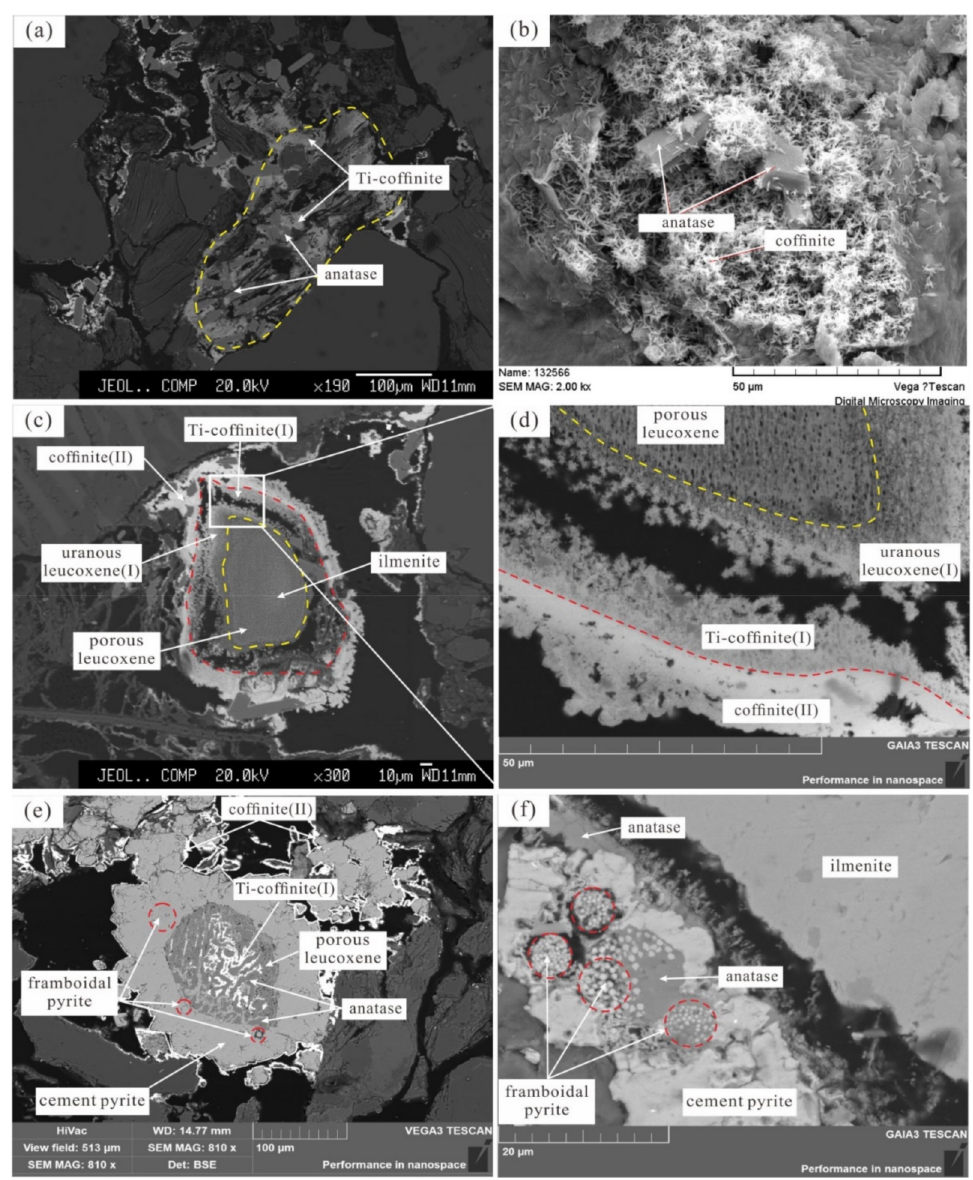
Figure 3. Alteration characteristics of altered ilmenite and its relationship with U minerals in sandstone-hosted U deposits in the Nalinggou U deposit in the northern Ordos Basin. ( a ) Completely altered ilmenite replaced by anatases and Ti-coffinite (BSE). ( b ) Coffinite in the form of burrs and needles produced around anatase (SE). ( c ) Partially altered ilmenite with minor amounts of residual ilmenite and mineral assemblage sequence of ilmenite, porous leucoxene, uraniferous leucoxene, Ti-coffinite and coffinite (BSE). ( d ) Mineral assemblage sequence of porous leucoxene, uraniferous leucoxene, Ti-coffinite and coffinite (SE). ( e ) Partially altered ilmenite replaced by anatases, porous leucoxene and Ti-coffinite, and coated by cement pyrite and coffinite (SE). ( f ) Polyframboidal compris- ing some framboids and individual framboids comprising pyritohedral or octahedral microcrystals in an ordered array